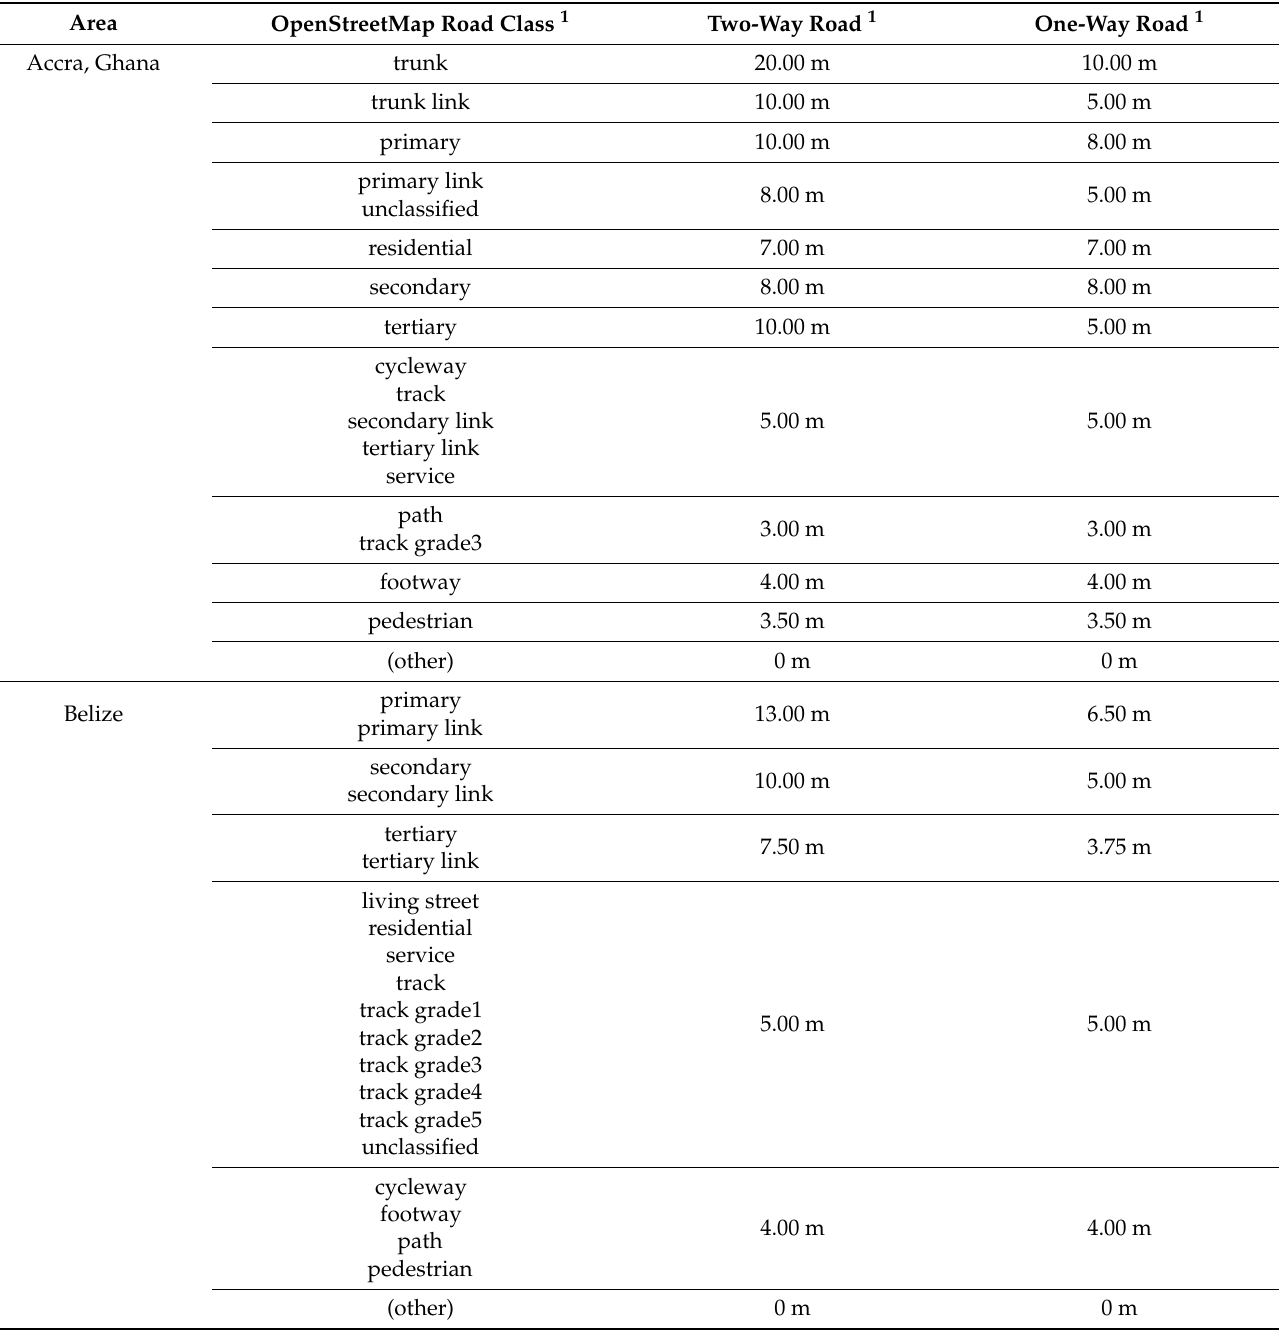
Table 3. Road classes and widths to calculate road area in each study